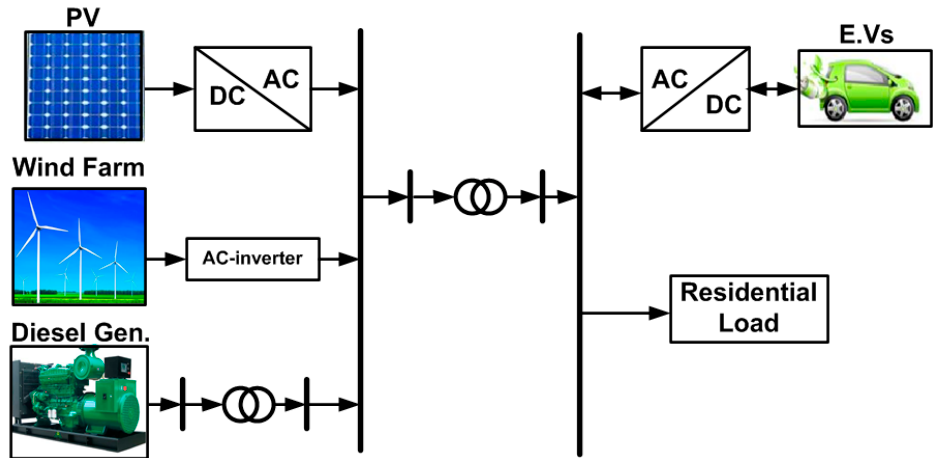
Figure 1. MG major components and configuration.